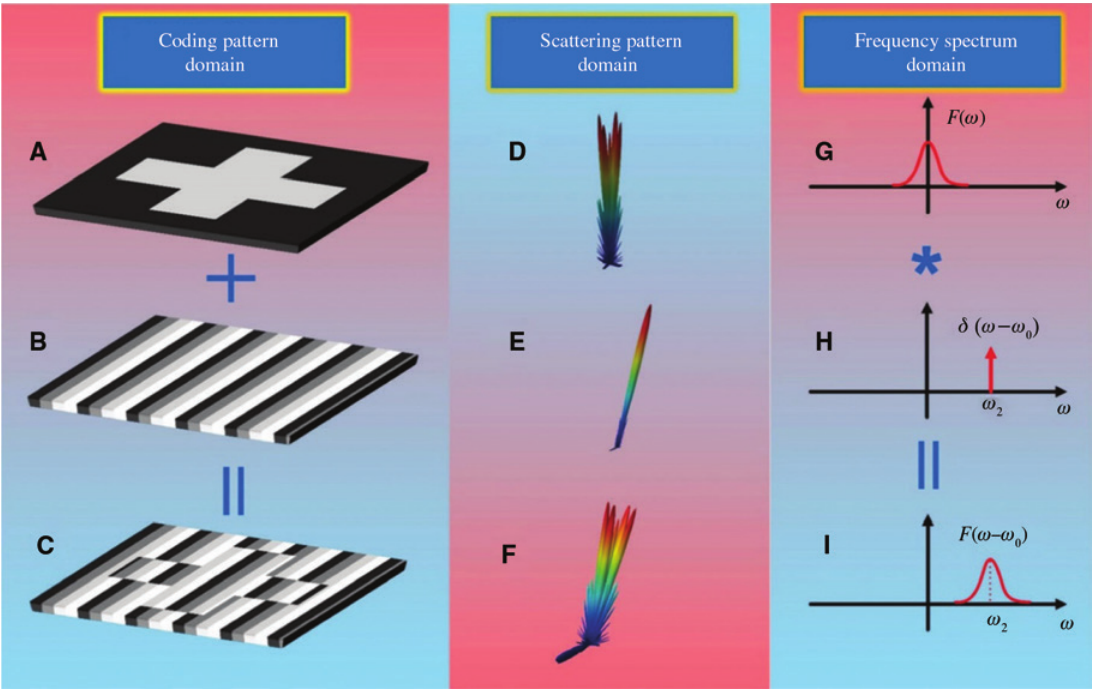
Figure 7: Principle of the scattering pattern shift. (A)–(C) The cross-shape coding pattern, gradient coding pattern, and mixed coding pattern, respectively. (D)–(F) The corresponding scattering patterns calculated by the FFT method. (G)–(I) The convolution theorem in signal processing. Adapted from